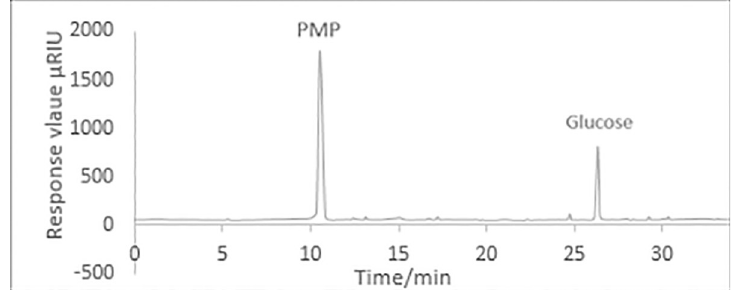
Fig 9. HPLC chromatogram of